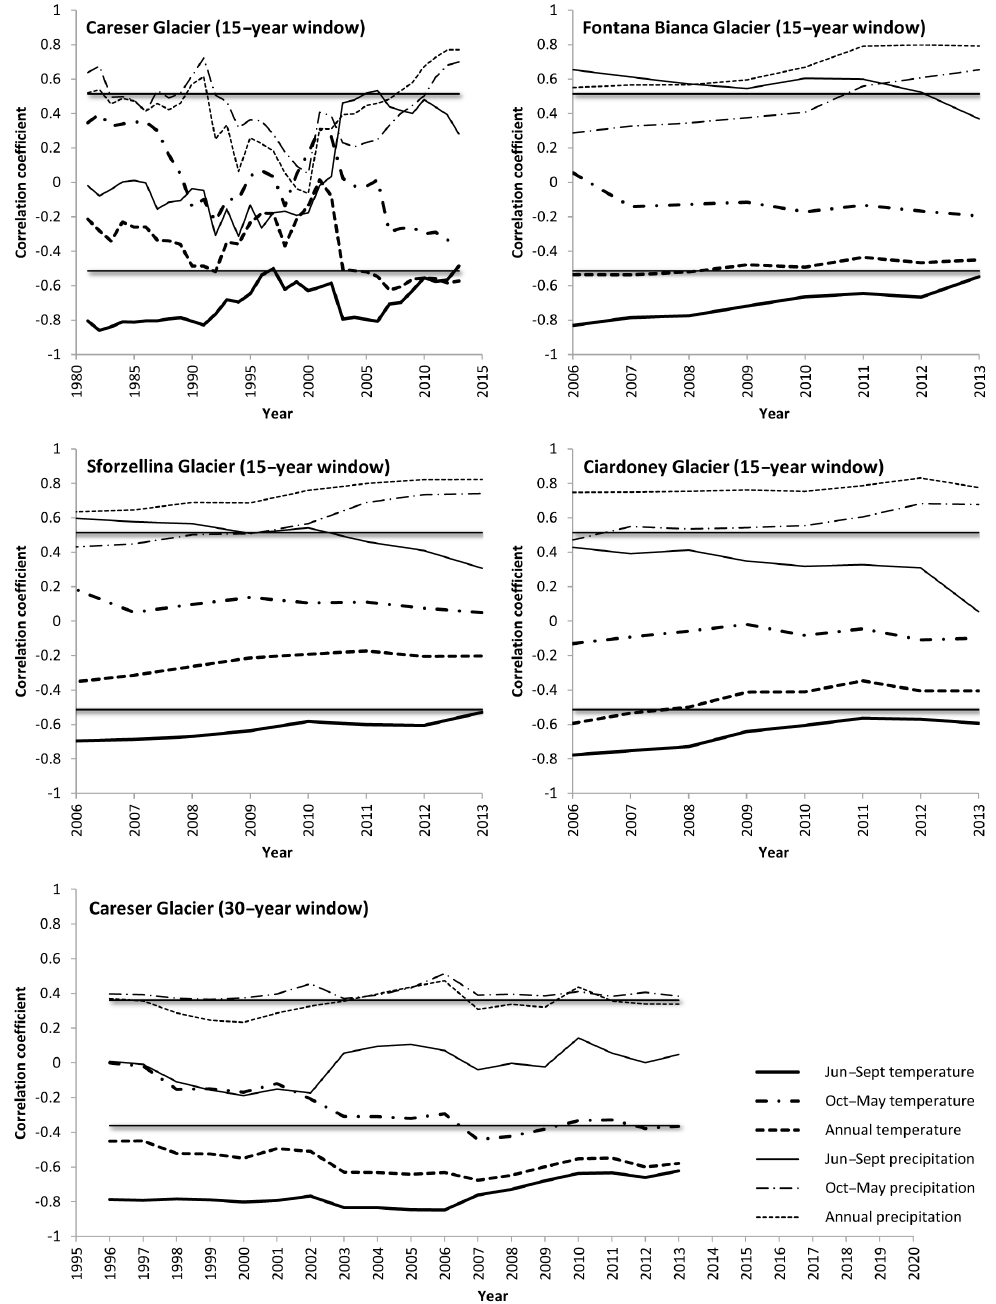
Figure 9. Bootstrapped moving correlation coefficient between annual mass balance and seasonal values of air temperature and precipitation. Shaded straight lines indicate significance at 95%